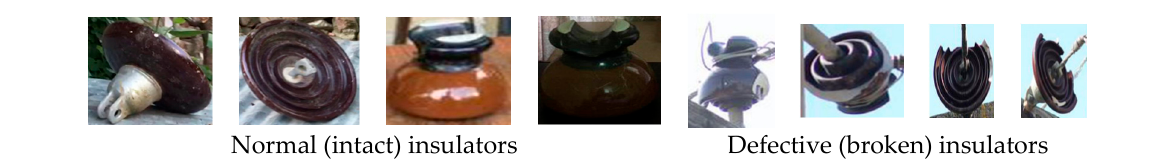
Figure 1. Depiction of insulators in overhead power distribution lines.